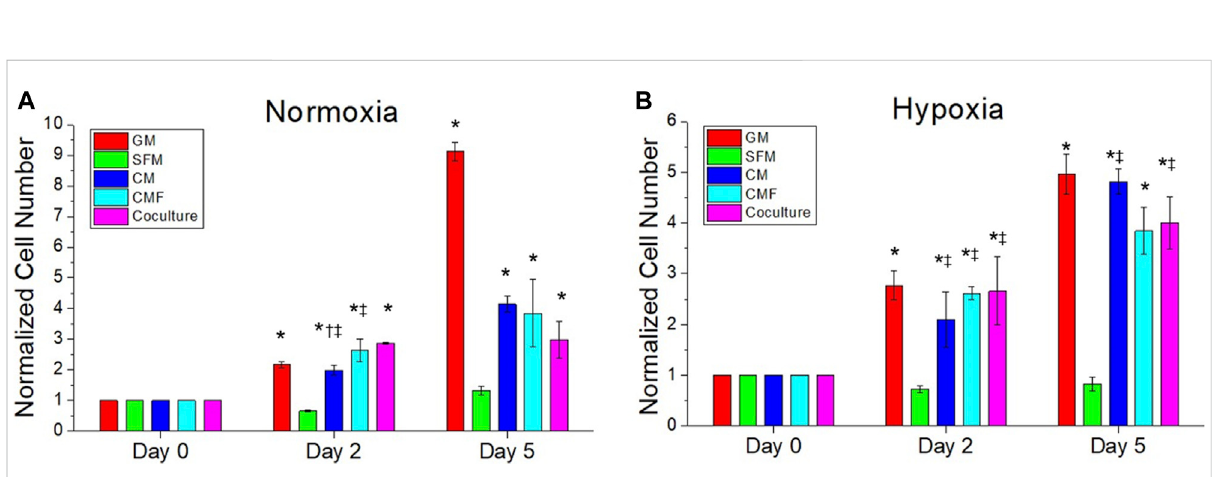
FIGURE 4 Theef fi cacyofCMFcomparedwithCMandhPSCco-culture.HDFistreatedwithgrowthmedium(GM),SFM,CM(6×),CMF(6×),andhPSC(co- culture with hPSC) for 0, 2, and 5 days in normoxia (A) and hypoxia (B) . Normalized cell numbers are measured using AlamarBlue assay. CMF has a similar effect to CM and co-culture treatment on HDF growth ( n = 3, duplicate measure, two-way ANOVA and Tukey ’ s test, * p < 0.05 with SFM, † p < 0.05 with CMF, ‡ p > 0.05 with